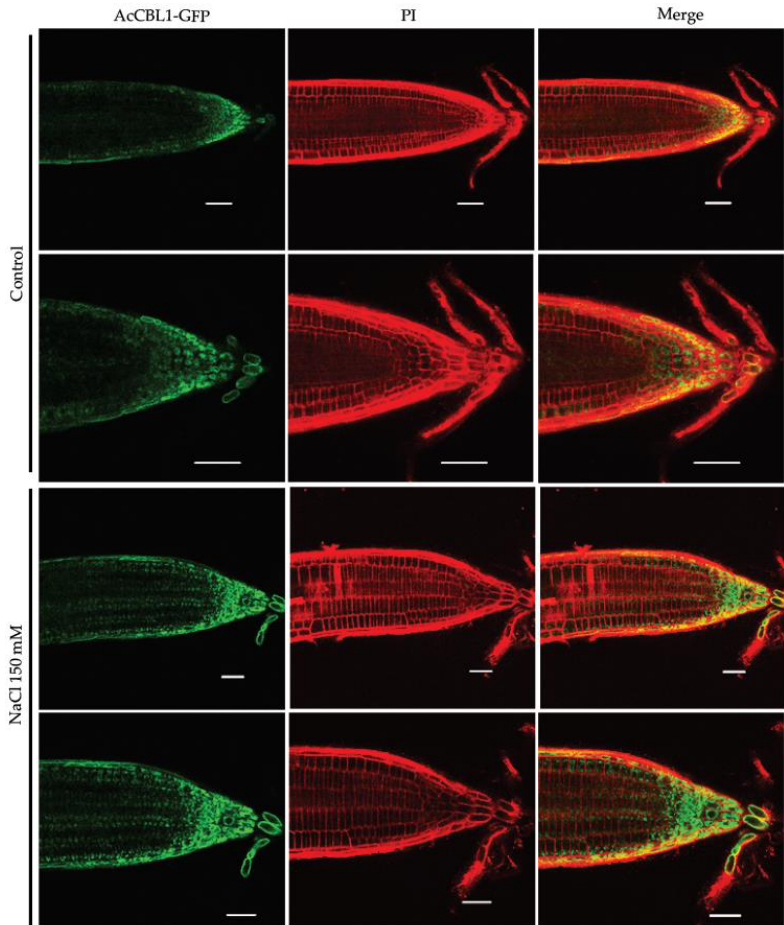
Figure 7. Ac CBL1-GFP localizes in cytosol under salt stress. Confocal analyses show Ac CBL1-GFP localization in the cytosol when of 5-day-old seedlings grown in the standard conditions were transferred in a medium containing 150 mM NaCl. GFP fluorescence is represented in green and propidium iodide (PI)fluorescence channel is represented in red. Scale bars = 50 μm.